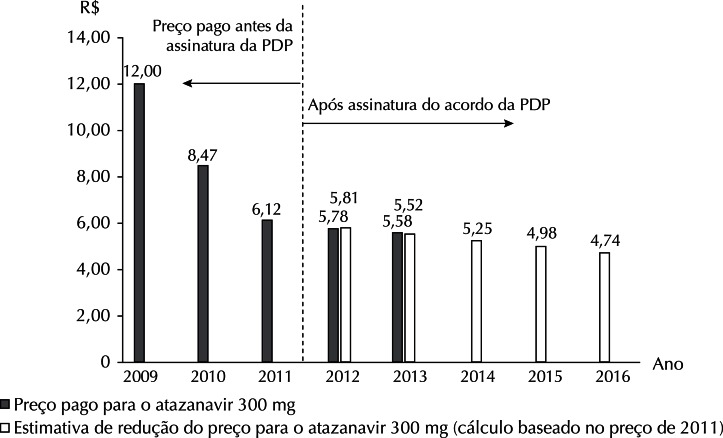
Preços pagos pelo atazanavir 300 mg e estimativa de redução após assinatura do acordo da Parceria para Desenvolvimento Produtivo. Brasil, 2009 a 2016.